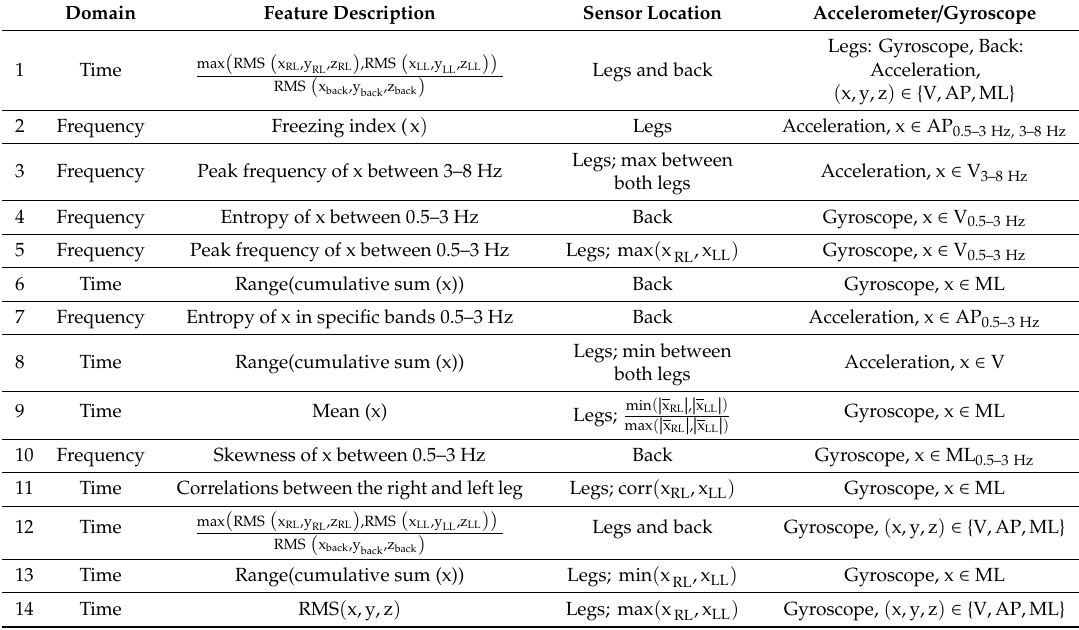
Figure 4. ROC (receiver operating characteristic) curves that illustrate the performance of the proposed SVM classifier. ( a ) Training set (blue) calculated from 57 iterations of a leave-one-patient-out validation process, AUC = 0.93, OOP: (0.12, 0.84). Test set (red), AUC = 0.94, OOP: (0.13, 0.88); ( b ) ROC curves of the OFF–ON states in the test set. OFF state (green), AUC = 0.95 OOP: (0.12, 0.89). ON state (yellow), AUC = 0.94: OOP: (0.12, 0.86). AUC, area under the curve; OOP, optimal operation point. Table 3. A set of 14 features that were used to train the final model with the SVM classifier. These features yielded the minimum classification loss and are rated in descending order, according to their significance to the model.